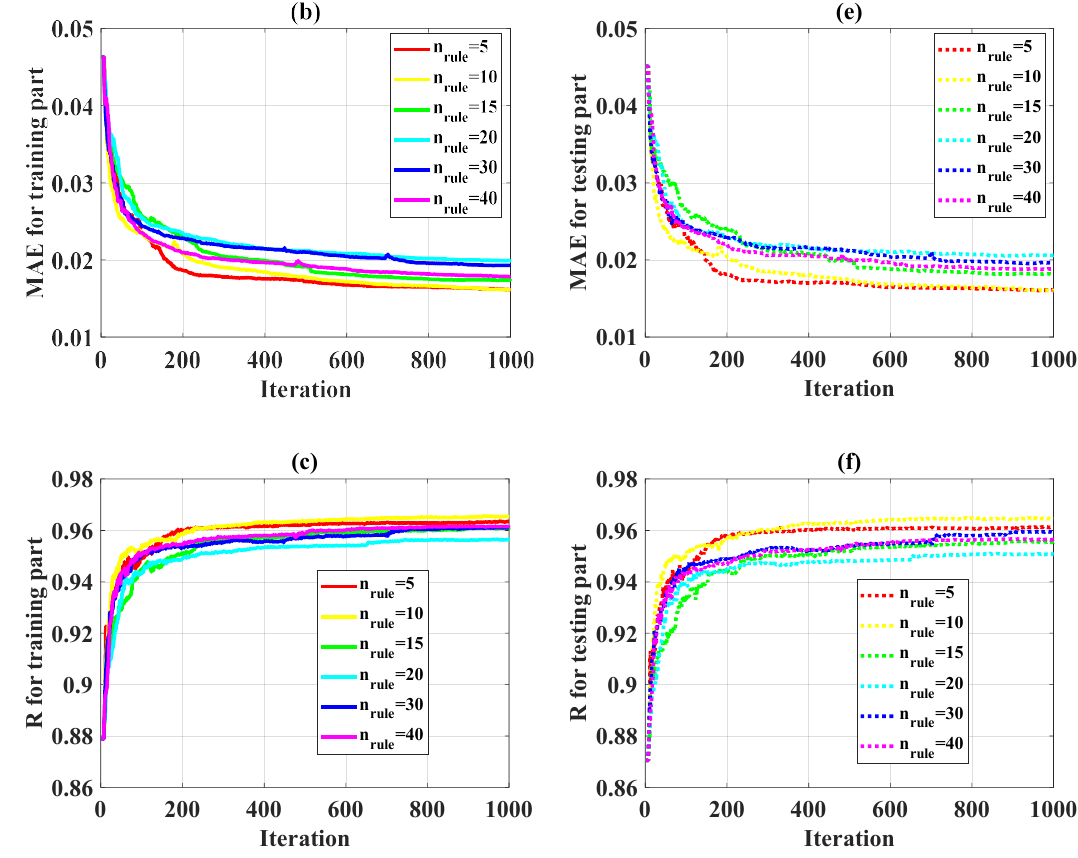
Figure 4. Convergence of several statistical criteria over 1000 iterations in terms of n rule for the training part: ( a ) RMSE, ( b ) MAE, ( c ) R. Convergence of several statistical criteria over 1000 iterations in terms of n rule for the testing part: ( d ) RMSE, ( e ) MAE, ( f ) R.